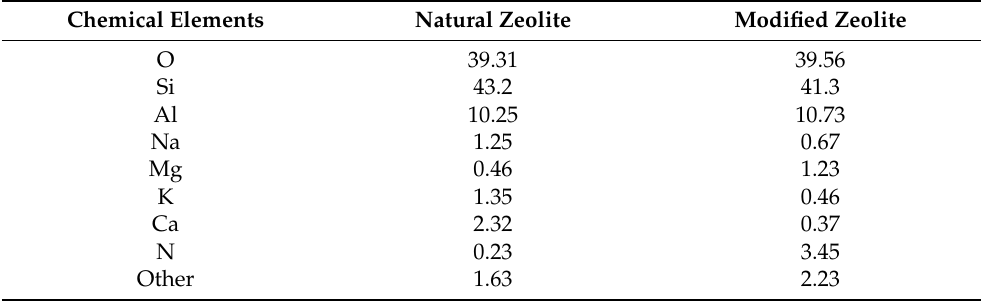
Table 1. Chemical compositions of the natural and modified zeolites by EDS (wt.%). Chemical